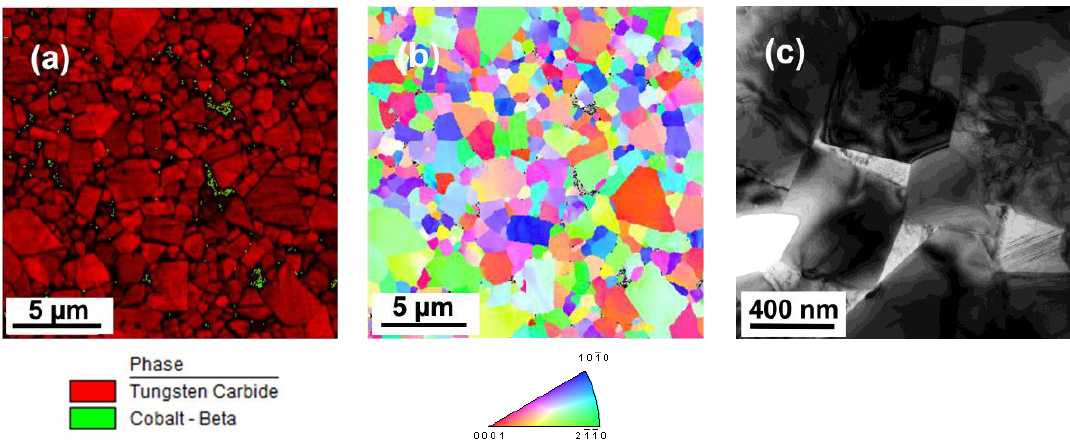
Figure 1. Typical morphologies of the untreated WC-6% Co observed under electron backscattered diffraction (EBSD) with ( a ) phase map; ( b ) orientation image mapping; and ( c ) under TEM. The scanning step was set at 30 nm.